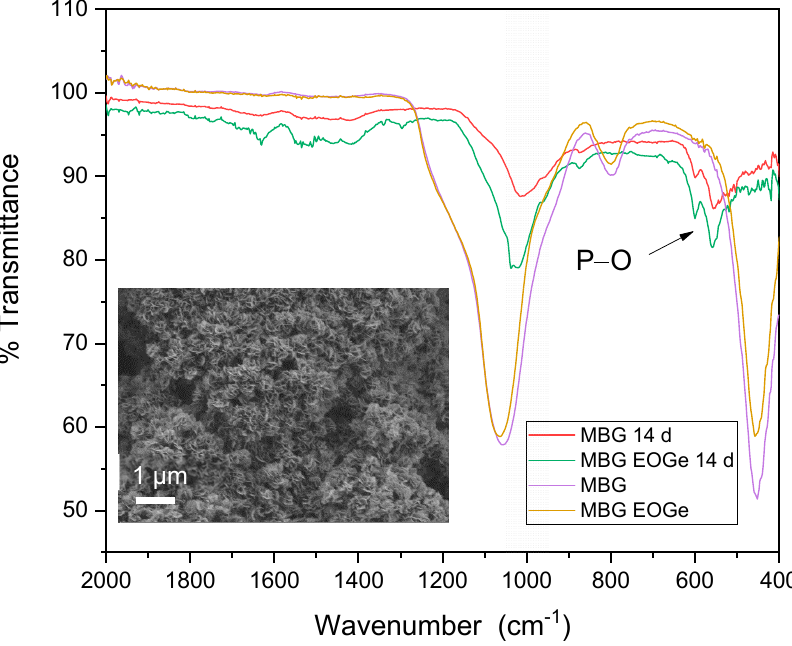
Figure 8. ATR-FTIR spectra of the MBG and MBG EOGe pellets before and after 14 days of immersion in SBF.